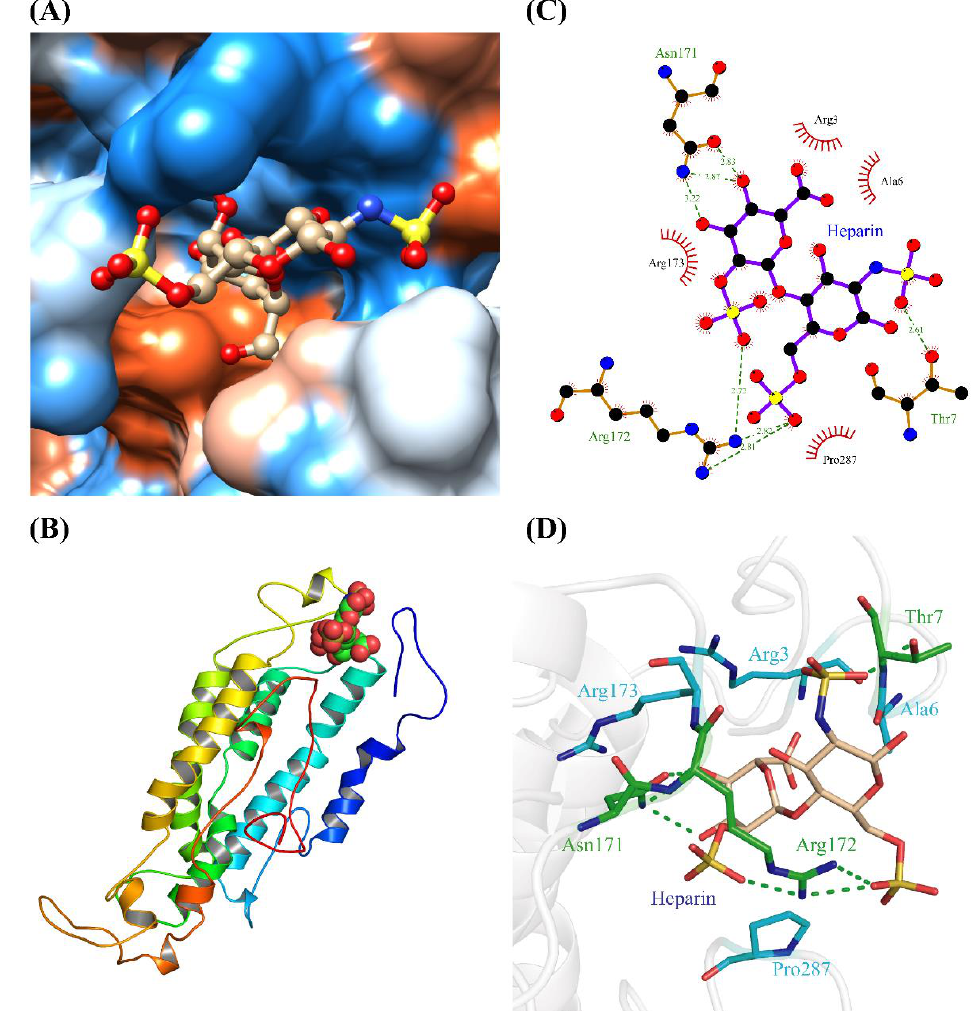
Figure 4. Interaction maps of binding pattern between heparin and OR2C1. ( A ) Heparin binding to the hydrophilic (blue) and hydrophobic (orange) surface of OR2C1; ( B ) position of heparin in 3D structure of OR2C1 protein; ( C ) ligand – protein interactions between heparin and OR2C1 with the residues that form H-bonding interaction (green) and hydrophobic interaction (red gear); ( D ) 3D binding pattern diagram of heparin and OR2C1, the H-binding are shown in green dotted line.